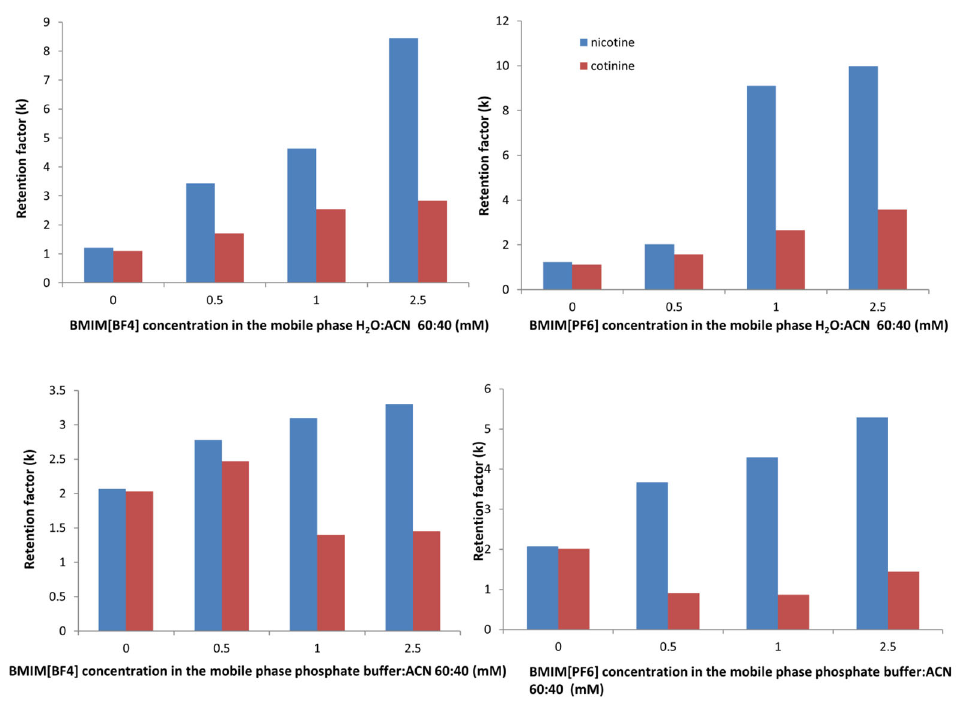
Figure 5. Effect of the concentration of ILs in the mobile phases on the retention factor, k, of the the analytes .